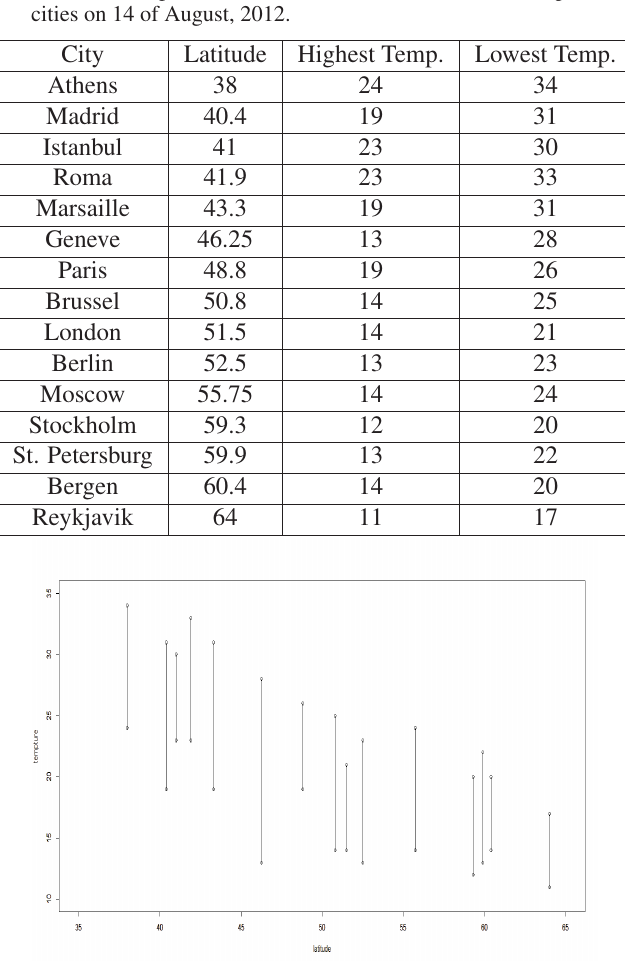
Table 3. Temperatures ( ◦ C ) and latitudes ( ◦ ) of 15 European cities on 14 of August, 2012.